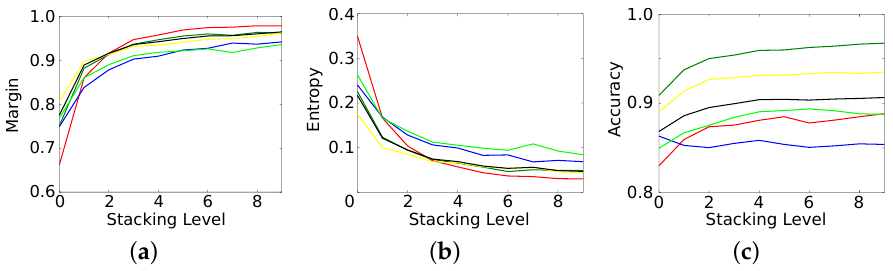
Figure 5. Results over the different stacking levels on the Oberpfaffenhofen dataset. Colors denote different classes (see Figure 3b), black denotes the average over all classes. ( a ) Margin; ( b ) Entropy; ( c ) Accuracy.